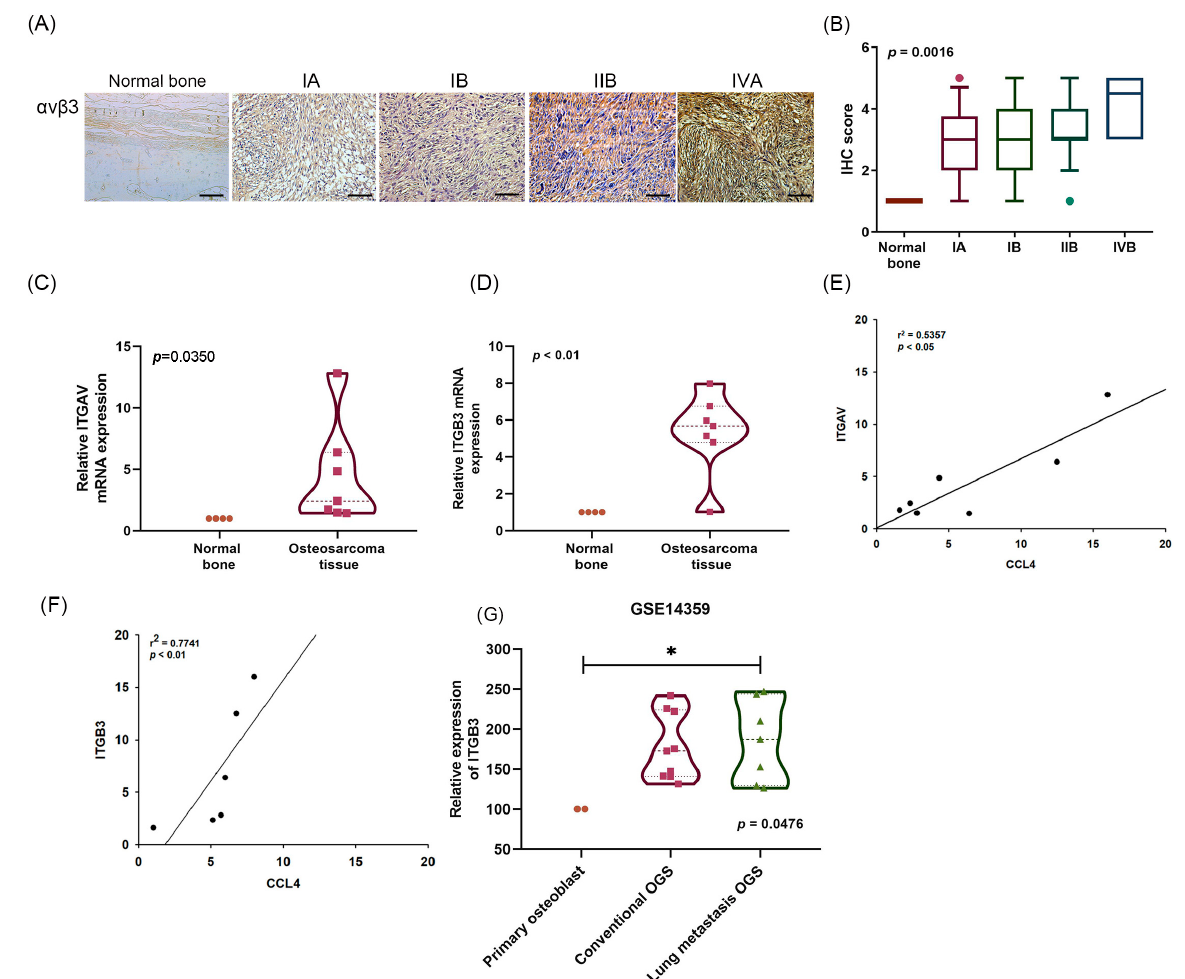
Figure 2. A positive correlation between CCL4 and integrin α v β 3 expression in osteosarcoma tissue. ( A , B ) Normal bone and osteosarcoma specimens were subjected to IHC evaluations with anti-integrin α v β 3 monoclonal antibody and the staining intensity was graded as 0 (no staining), 1 (<25% of the cells with positive staining), 2 (25–49% of the cells with positive staining), 3 (50–74% of the cells with positive staining), or 4 (50–100% of the cells with positive staining) (scale bar = 100 µ m). ( C , D ) Levels of integrin α v (ITGAV) ( C ) and integrin β 3 (ITGB3) ( D ) mRNA expression in normal bone and osteosarcoma tissue were detected by qPCR. Analysis of correlations between CCL4 and ITGAV ( E ) or ITGB3 ( F ) mRNA expression in osteosarcoma tissue. ( G ) Levels of integrin β 3 (ITGB3) mRNA expression in primary osteoblasts, conventional OGS, and lung metastatic OGS were analyzed using records from the GEO Dataset GSE14359. * p < 0.05 compared with controls.